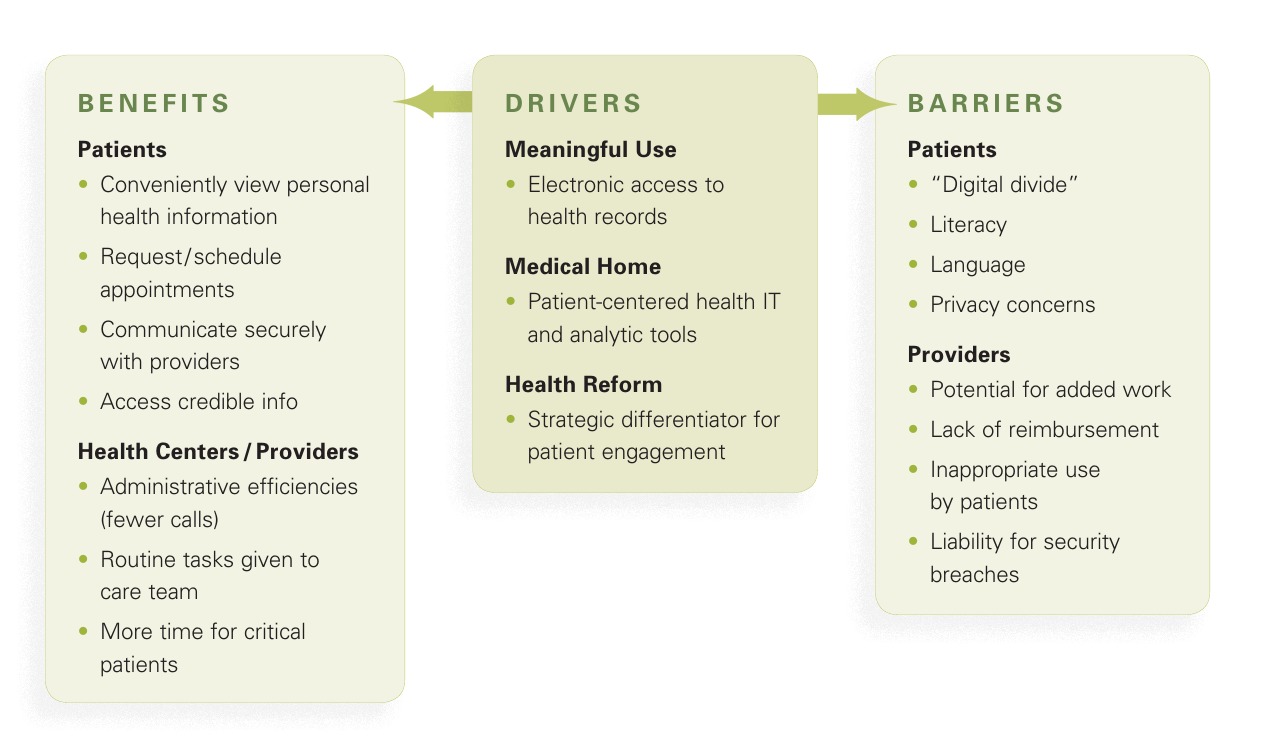
Figure 1. Drivers, Benefits, and Barriers to Patient Portal Implementation